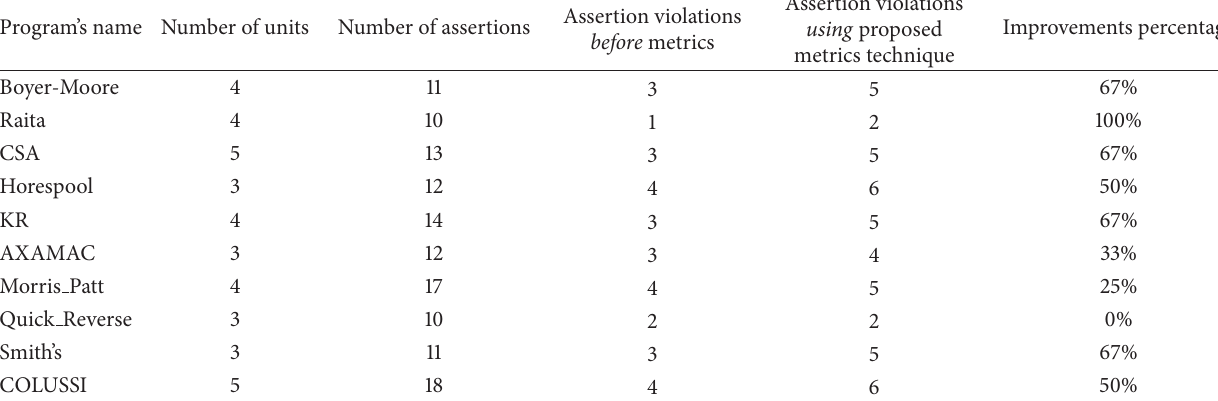
Table 2: Statistics of assertion